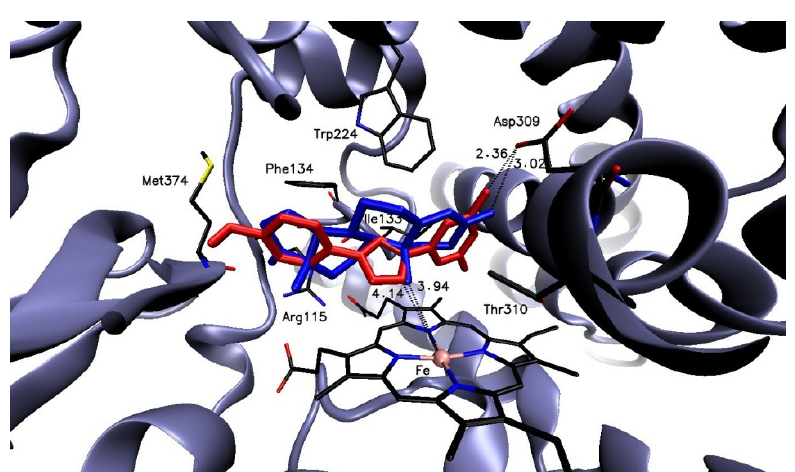
Figure 5. The binding mode of compound 6b (red) and androstenedione (blue) in the AROM active site.